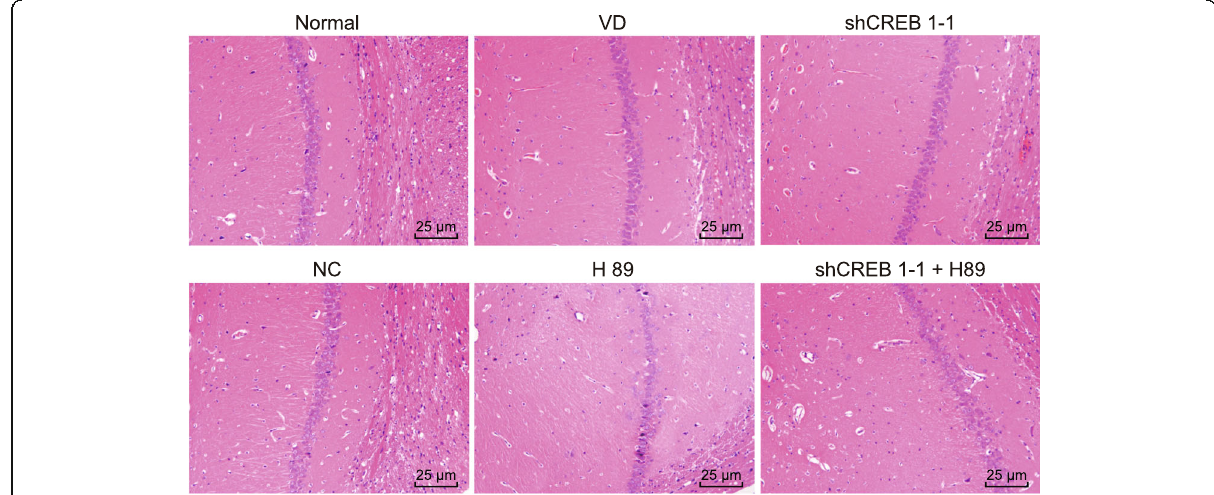
Fig. 3 Pathological changes of hippocampal neurons of mice injected with shCREB1 – 1 and H89 are most serious, Note: CREB1, cyclic adenosine monophosphate responsive element-binding protein